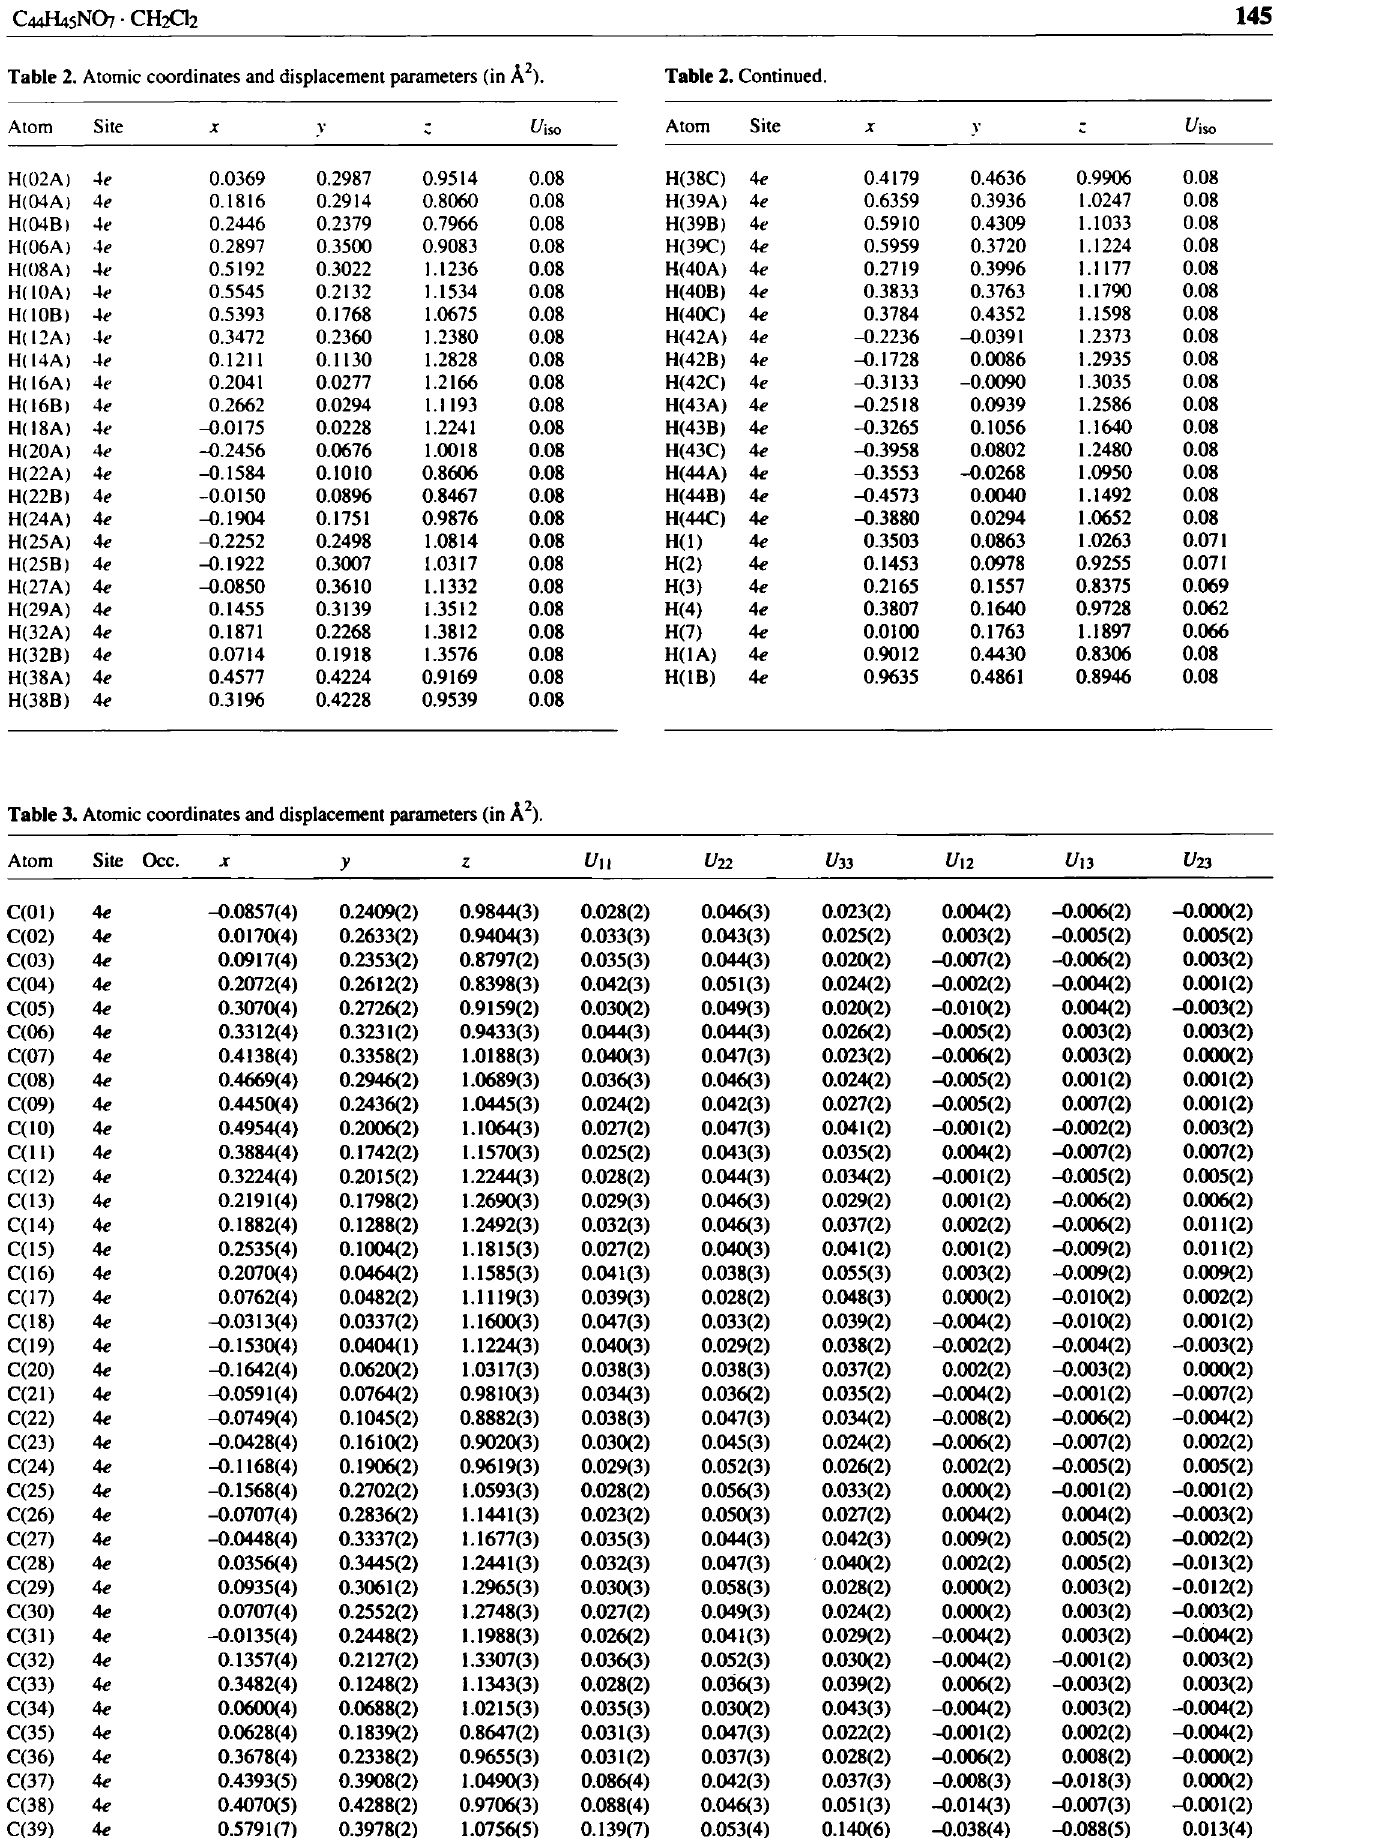
Table 2. Atomic coordinates and displacement parameters (in A 2 ).